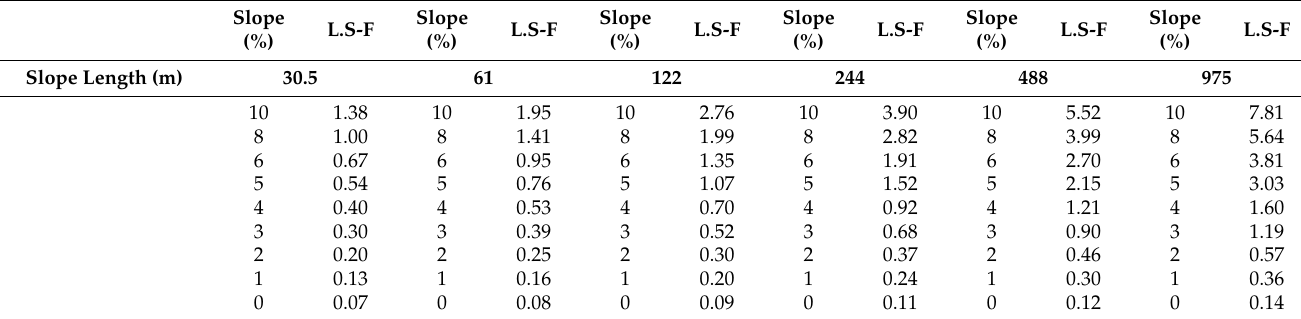
Table 6. Slope length and slope steepness factors (LS-Factor)